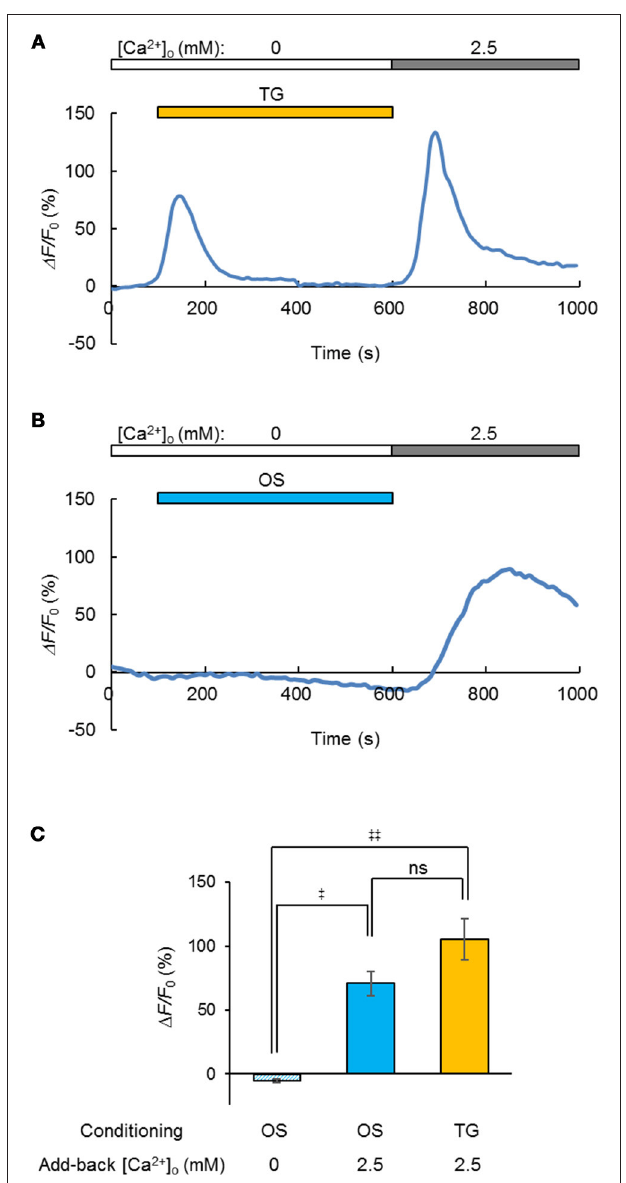
FIGURE 5 | Light-induced store-operated Ca 2 + entry (SOCE). (A) The SOCE was observed by the [Ca 2 + ] o add-back from 0 to 2.5mM after depletion of the intracellular Ca 2 + store by thapsigargin (TG, orange stripe, 5 µ M), while the change of R-GECO1 fluorescence ( 1 F / F 0 ) was recorded (0.1 fps) from a ChRGR ER -expressing C2C12 cell. (B) Similar to (A) , but the OS (blue stripe, 475 ± 10nm, 10ms pulse at 20Hz for 0.5s) was repetitively applied (50 cycles at every 10s). Note that the OS increased the fluorescence only slightly because it was applied between the sampling of images. (C) Summary of the OS-induced SOCE: without add-back [Ca 2 + ] o after OS (left, n = 7), with add-back [Ca 2 + ] o after OS ( n = 12) and with add-back [Ca 2 + ] o after TG ( n = 8). ‡ P < 0.05; ‡‡ P < 0.01; ns, P > 0.1; one-way Kruskal-Wallis test by ranks.